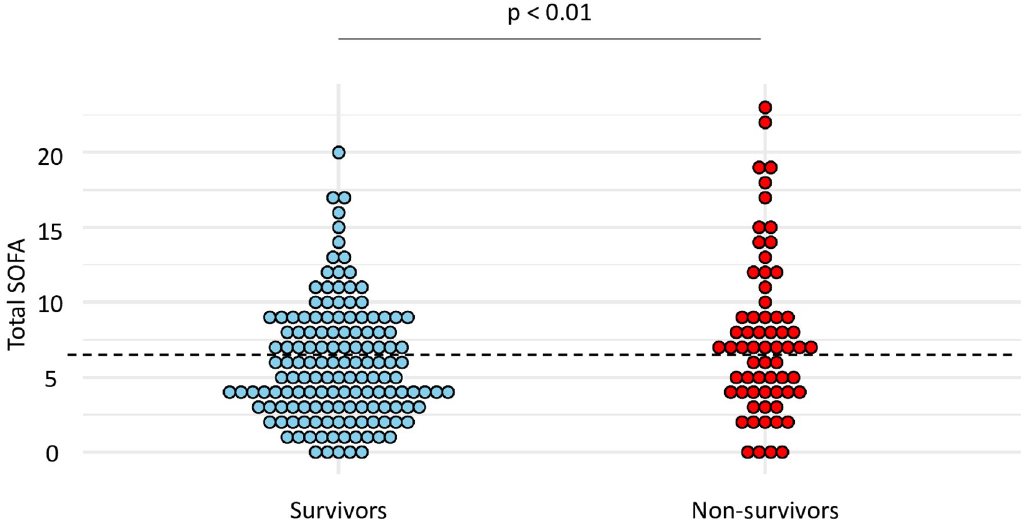
Fig 5. Dot plots of total SOFA in survivors and non-survivors. Values of total SOFA are shown as single dots for each patient. The dash line separates patients with a total SOFA � 7 from those with a total SOFA < 7. SOFA sequential organ failure